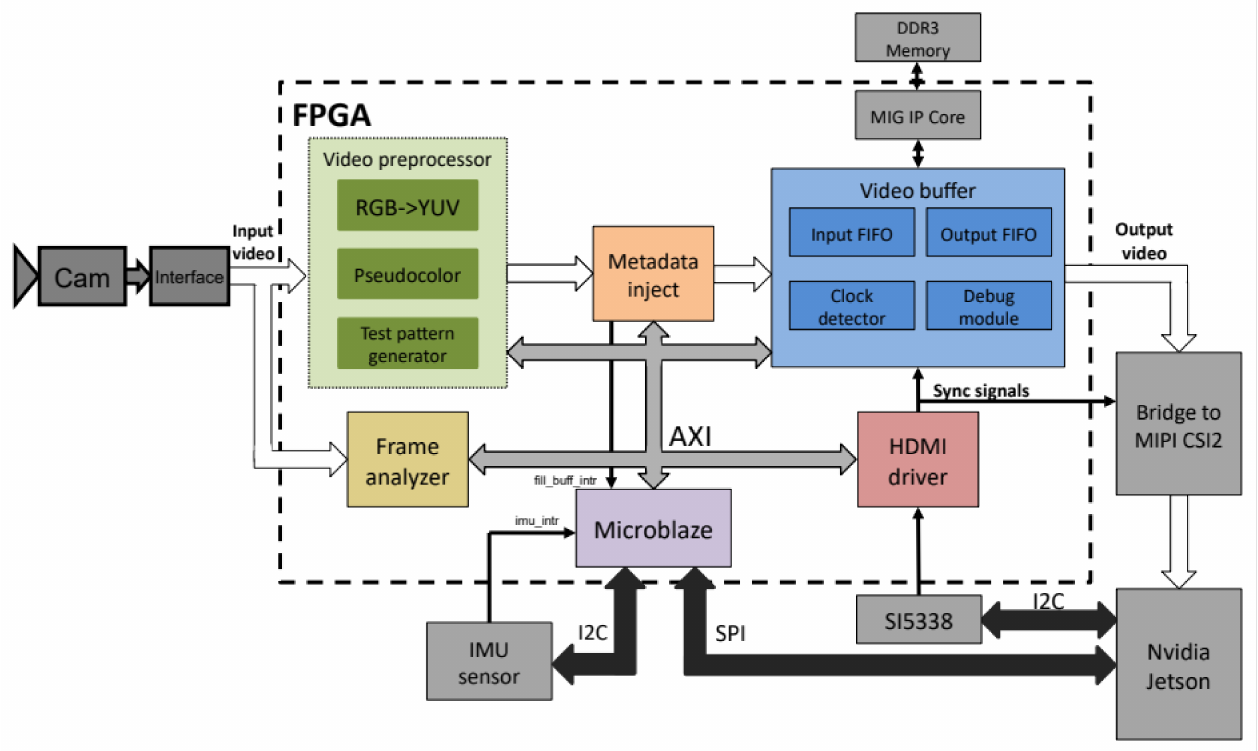
Figure 4. FPGA code